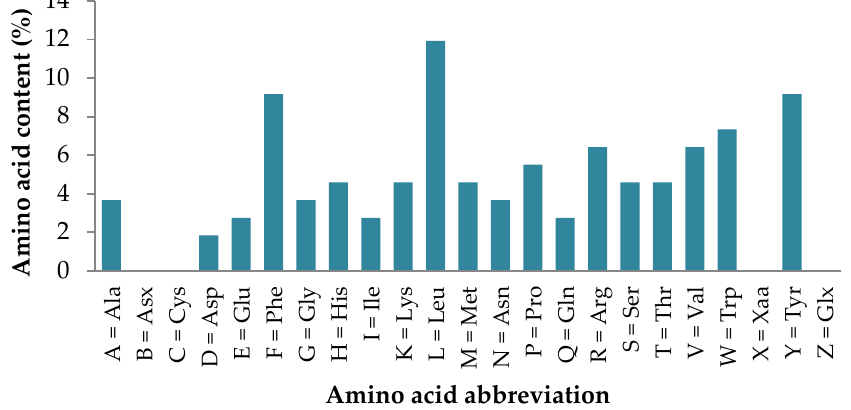
Figure 2. Percentage share of amino acids present in the sequences of bioactive peptides inhibiting the activity of the DPP-IV enzyme.